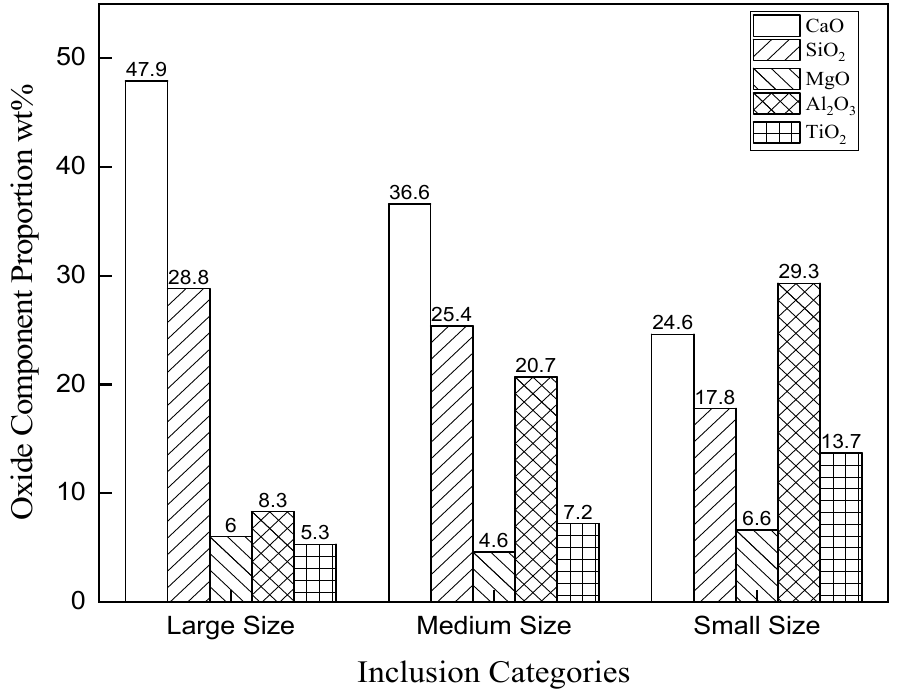
Figure 5. Oxide component proportion in different sized CaO-Al 2 O 3 -SiO 2 -(MgO)-TiO x inclusions. The CaO-Al 2 O 3 -SiO 2 -MgO-TiO x inclusions’ composition at different stages was